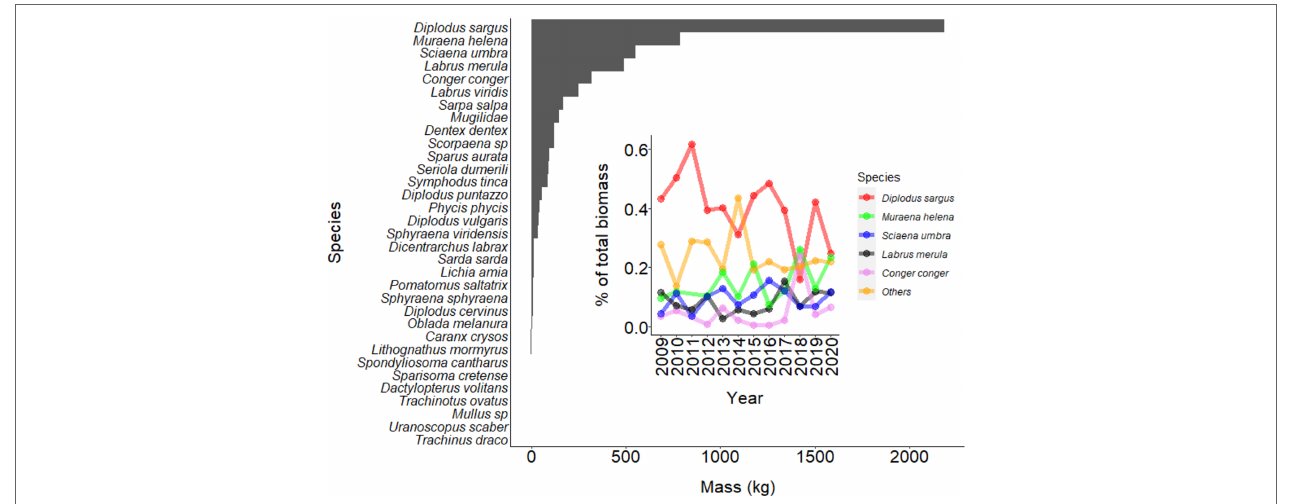
FIGURE 3 | The total biomass and temporal changes of species caught by spearfishers during Italian marine spearfishing tournaments from 2009 to 2020 (N total = 8843; N D. sargus = 4286; N M. Helena = 362; N S. umbra = 759; N L. merula = 1018; N C. conger = 101; N others =